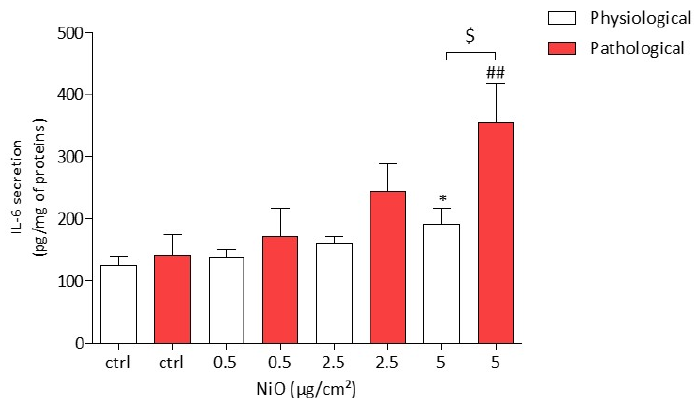
Figure 5. IL-6 production in HPAEC after a 24 h exposure to NiONPs (0.5–5 µ g/cm 2 ) under physio- logical and pathological conditions measured by ELISA. The results were expressed as pg/mg of protein. Data are mean ± SEM of five independents experiments ( n = 5) performed in quadruplicate. * p < 0.05 vs. untreated cells in 0% CS in normoxic conditions. ## p < 0.01 vs. untreated cells in patho- logical conditions. $ p < 0.05 between both conditions. According to Kruskal–Wallis test followed by a Dunn’s multiple comparison test.